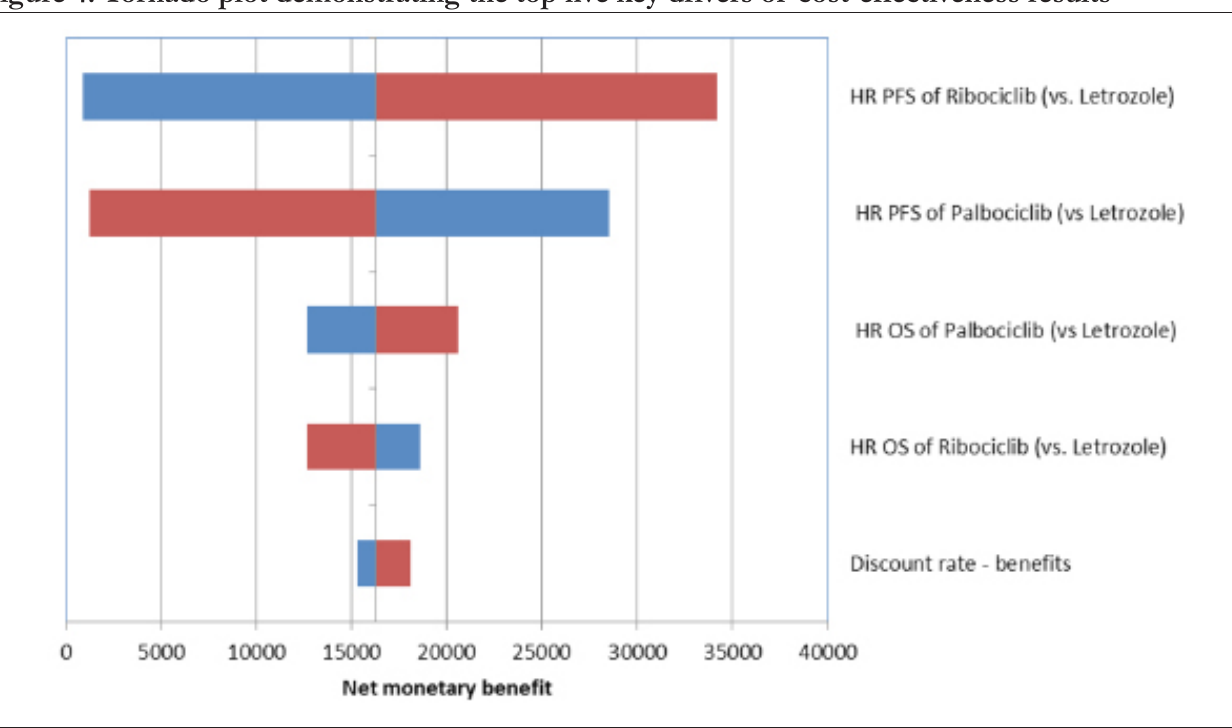
HR: Hazard ratio; OS: Overall survival; PFS: Progression-free survival; vs.: